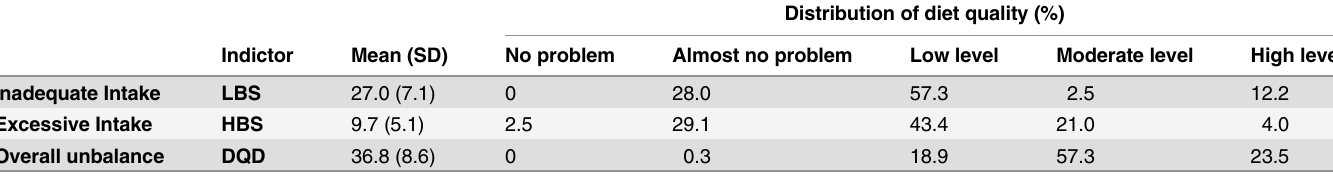
Table 3. Distribution of diet quality among older Chinese people (%).